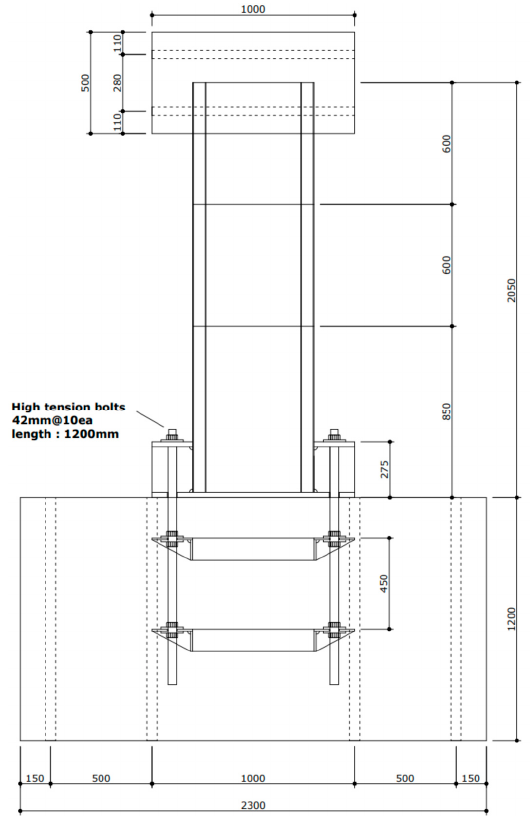
Figure 14. Design of tower specimen.